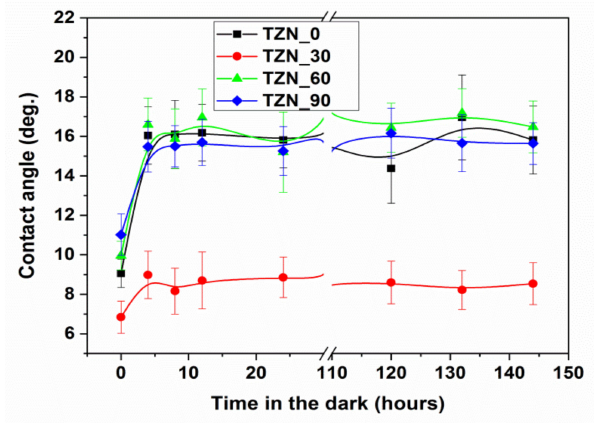
Figure 9. Time evolution of the static contact angle values of the samples during